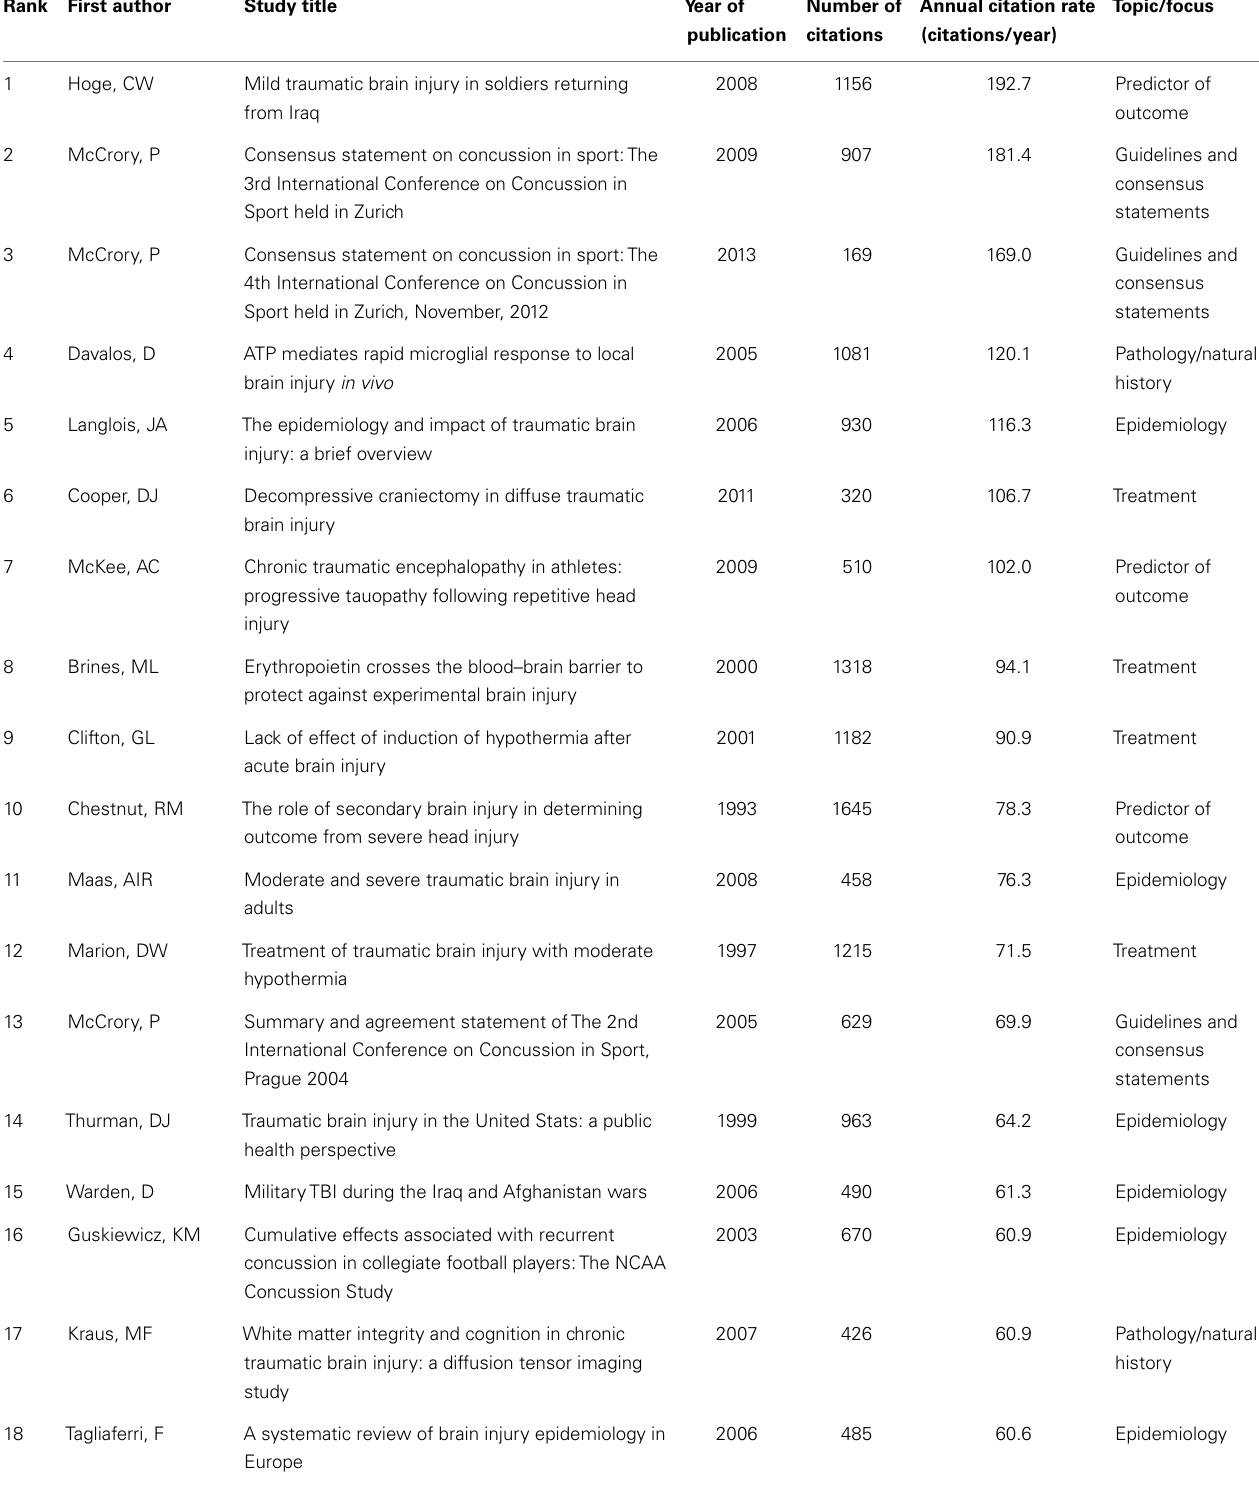
Table 2 |TBI publications with the highest annual citation rates ( n = 50)